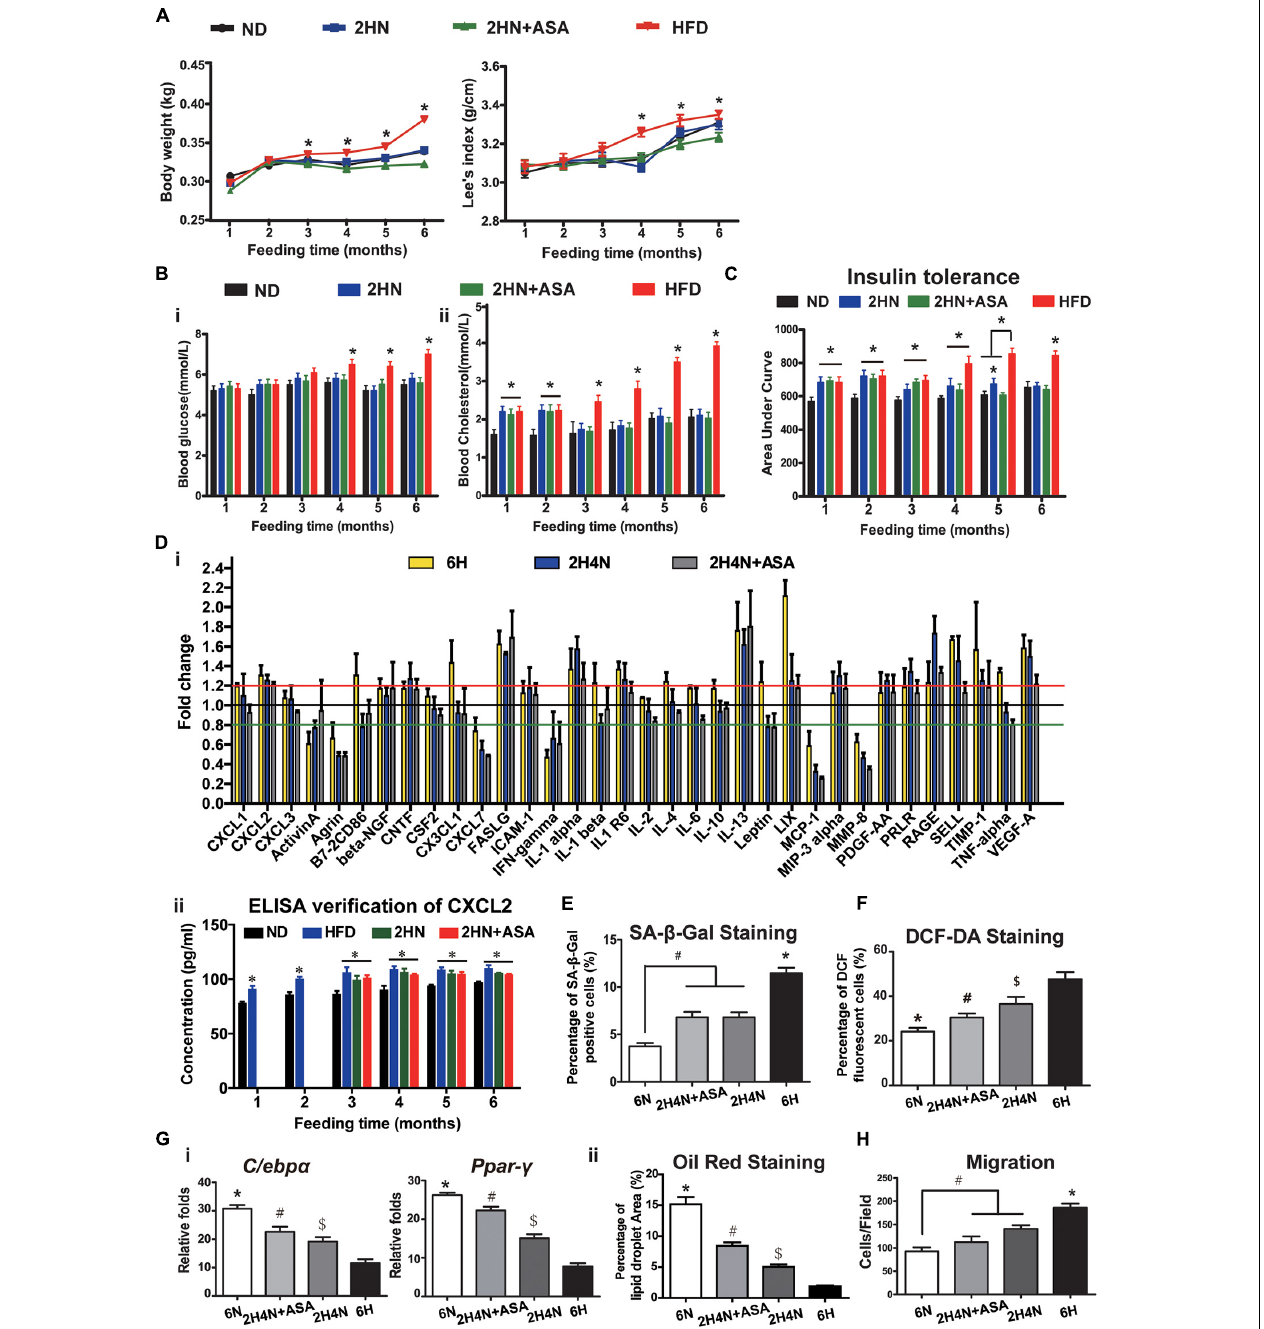
FIGURE 9 | Aspirin administration promotes recovery of insulin tolerance and ameliorates the cytokine profiles in rats, while partially reversing CXCL2 level and BMSC functions. (A–C) Body weight gain and Lee’s index (A) , blood glucose and cholesterol levels [ (B) n = 10] and insulin tolerance [ (C) n = 5] of rats in the ND, HFD, 2HN and 2HN+ASA groups over 6 months of feedings. (D) Serum cytokine profiles of rats in the 6H, 2H4N and 2H4N+ASA groups (i) . Data are presented as the mean of fold changes ± SEM ( n = 3) in comparison with 6N rats. ELISA was applied to verify the serum CXCL2 levels (ii) , n = 3. Significance was calculated by one-way ANOVA followed by Tukey’s post hoc test, * p < 0.05. (E) SA- β -Gal staining of senescent BMSCs. * p < 0.05 (6H versus another 3 groups), # p < 0.05 (6N versus 2H4N and 2H4N+ASA). (F) DCF-DA staining of BMSCs. * p < 0.05 (6N versus another 3 groups), # p < 0.05 (2H4N+ASA versus 2H4N and 6H), $ p < 0.05 (2H4N versus 6H). (G) Adipogenic differentiation potential of BMSCs were assessed by the expressions of adipogenic markers (i) in BMSCs and quantification of percentage of oil red-stained lipid droplet area (ii) . Significance was calculated by one-way ANOVA followed by Tukey’s post hoc test, * p < 0.05 (6H versus another 3 groups), # p < 0.05 (2H4N+ASA versus 2H4N and 6H), $ p < 0.05 (2H4N versus 6H). (H) Migration capacities of BMSCs in 6N, 6H, 2H4N and 2H4N+ASA groups. Significance was calculated by one-way ANOVA followed by Tukey’s post hoc test, # p < 0.05 (2H4N and 2H4N+ASA versus 6N), * p < 0.05 (6H versus another 3 groups). n =